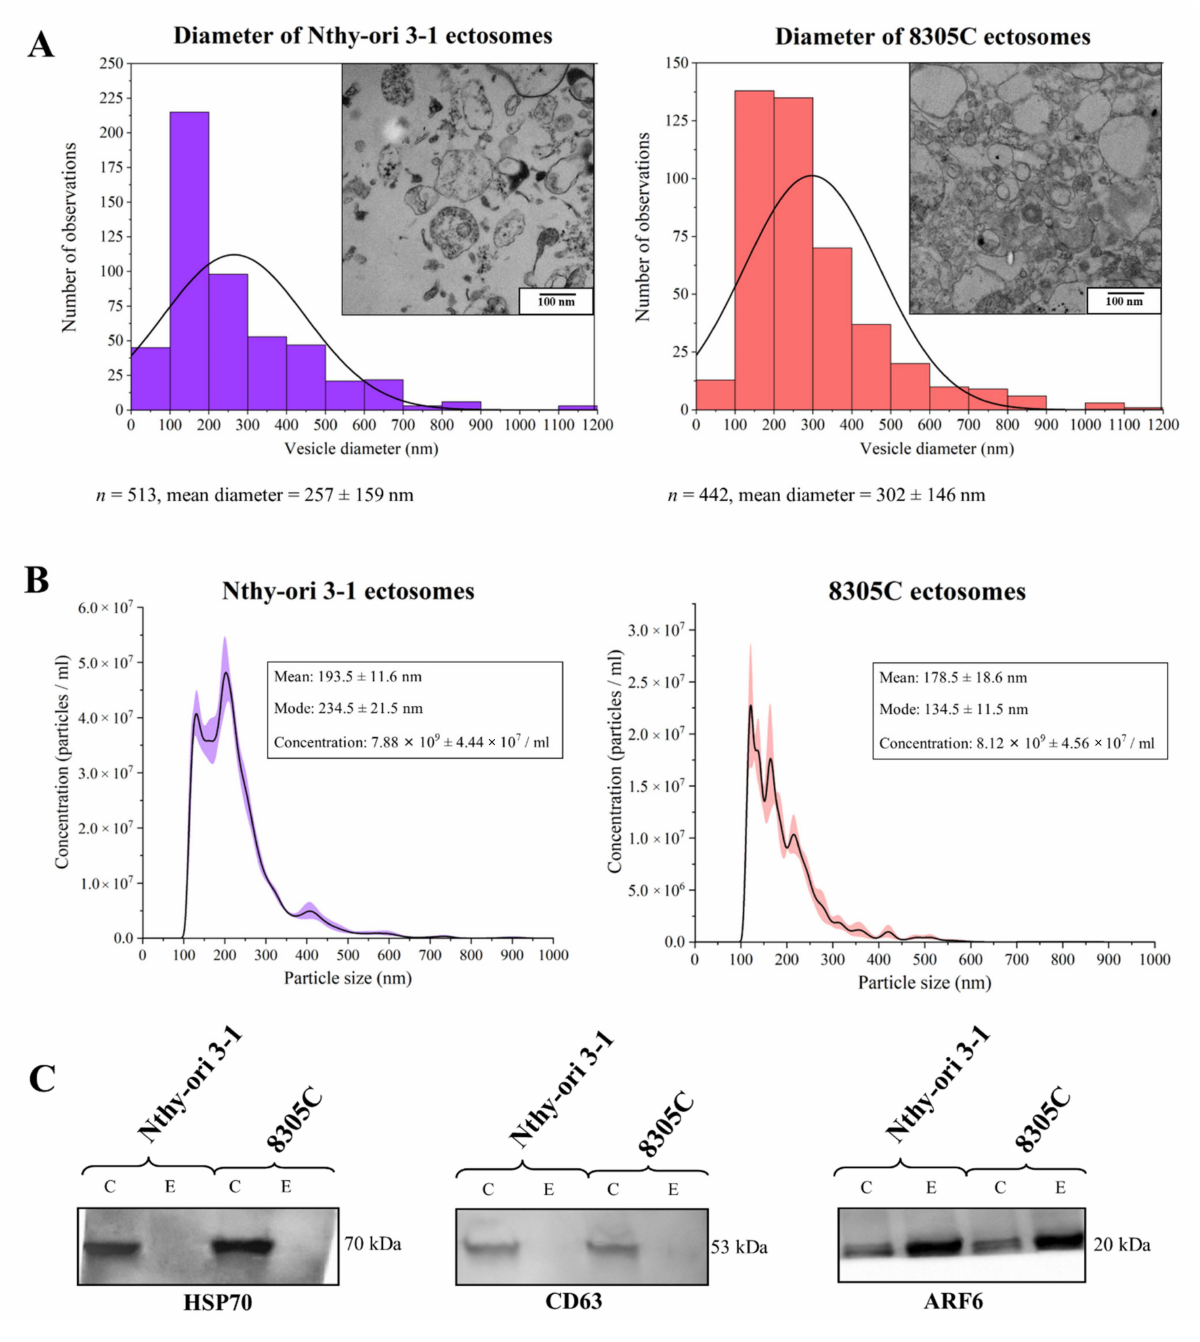
Figure 1. Characterization of ectosome samples isolated from conditioned media of normal thyroid follicular epithelial Nthy-ori 3-1 cells and thyroid anaplastic carcinoma 8305C cells. ( A ) Morphological characterization of Nthy-ori 3-1- and 8305C-derived ectosomes by transmission electron microscopy (TEM). Size distributions are presented on histograms. Mean diameter ± standard deviation was calculated for all observed vesicles (n) from a respective sample. ( B ) Nanoparticle tracking analysis (NTA) of Nthy-ori 3-1- and 8305C-derived ectosomes. Results from five independent measurements for each cell line are presented as graphs. The shaded area depicts standard deviation. ( C ) Representa- tive Western blot of extracellular vesicle markers in whole-cell protein extracts (line C) and ectosome samples (line E). After being separated by 10% SDS–PAGE and transferred into PVDF membrane, 50 µ g of proteins were probed with anti-HSP70 (1:2000), anti-CD63 (1:2000), and anti-ARF6 (1:500) as primary antibodies, and anti-mouse IgG-HRP (1:400) as a secondary